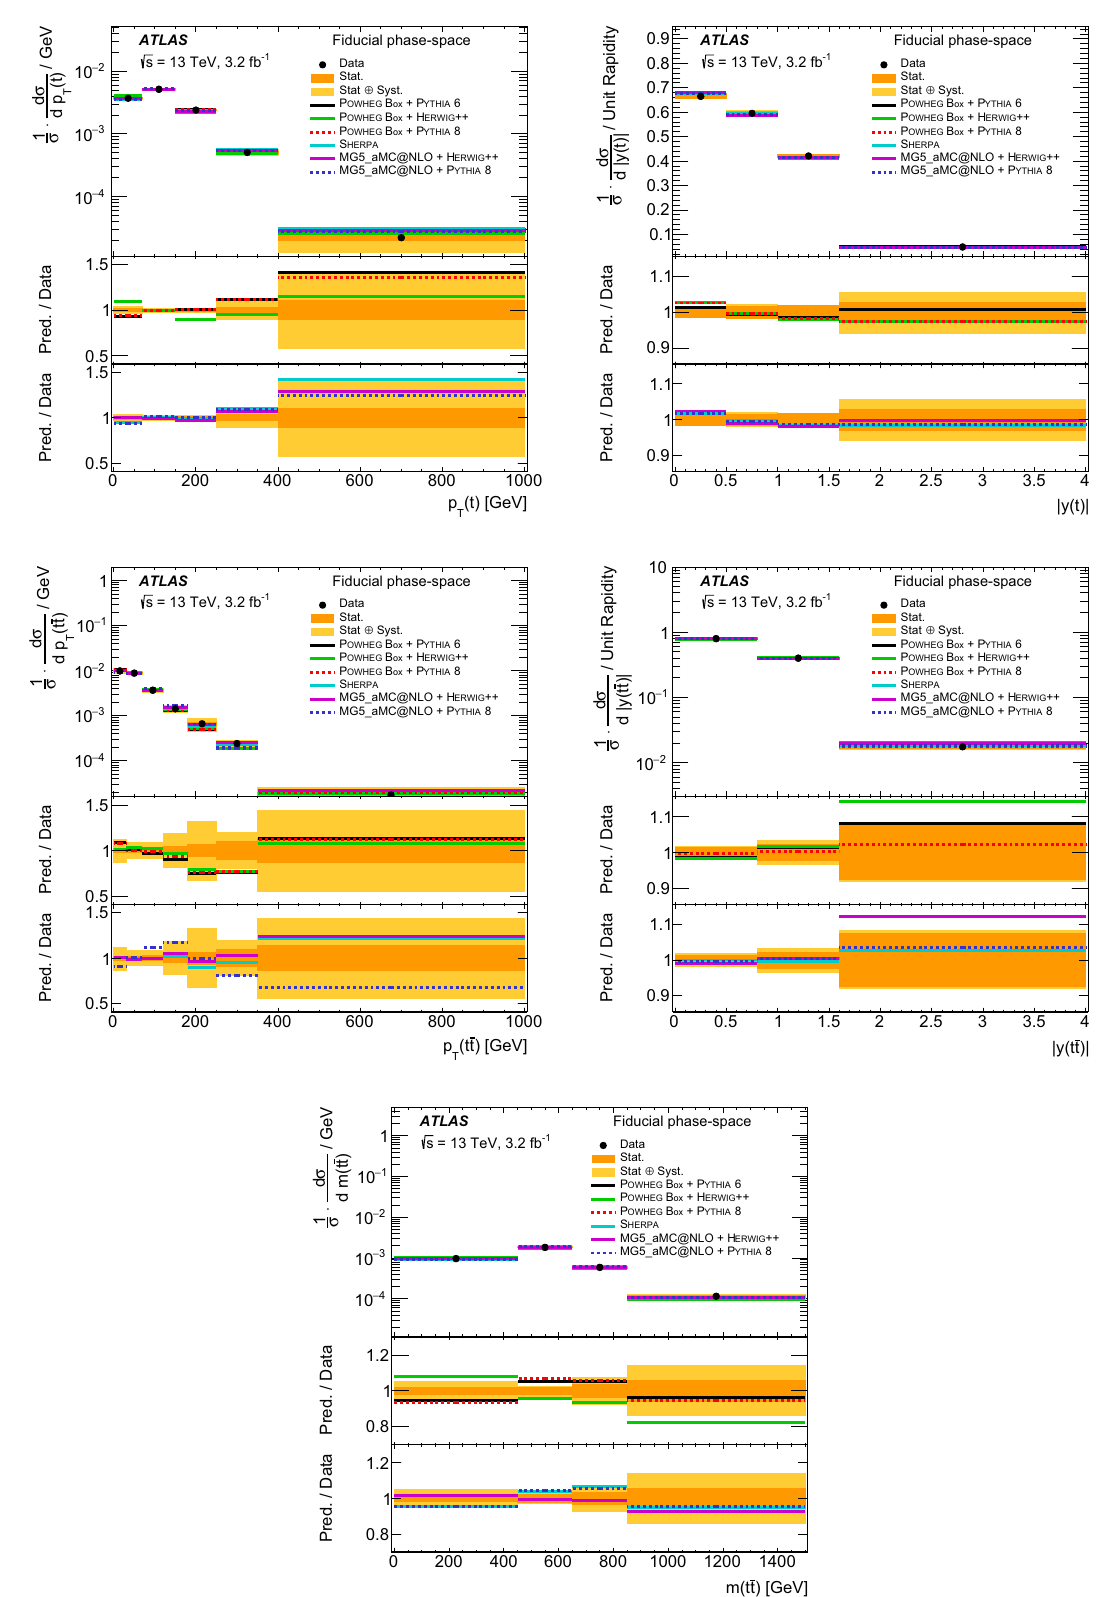
Fig. 5 The measured normalised fiducial differential cross-sections compared to predictions from Powheg -Box ( top ratio panel ), MG5 _aMC@NLO, and Sherpa ( bottom ratio panel ) interfaced to various parton shower